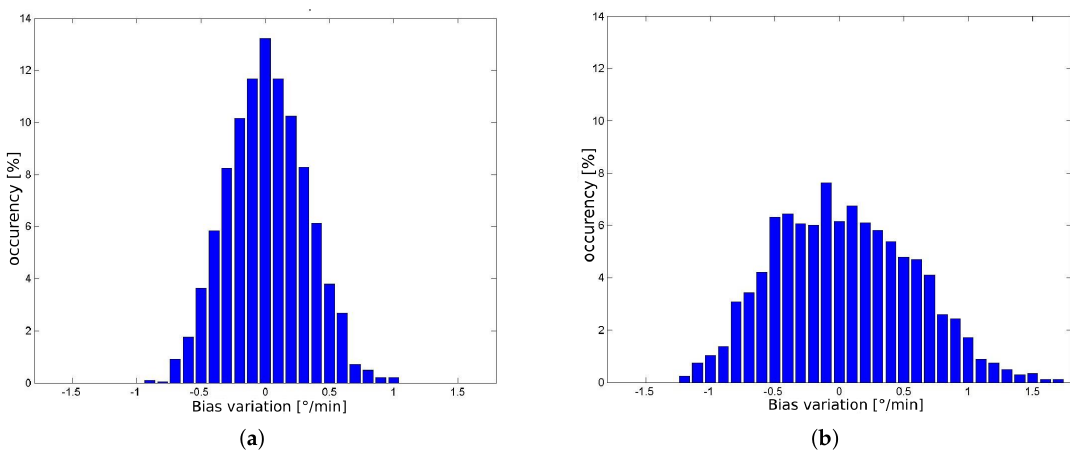
Figure 21. Histogram of the mean bias error caused by low frequency noise: ( a ) for 18 min; ( b ) for 60